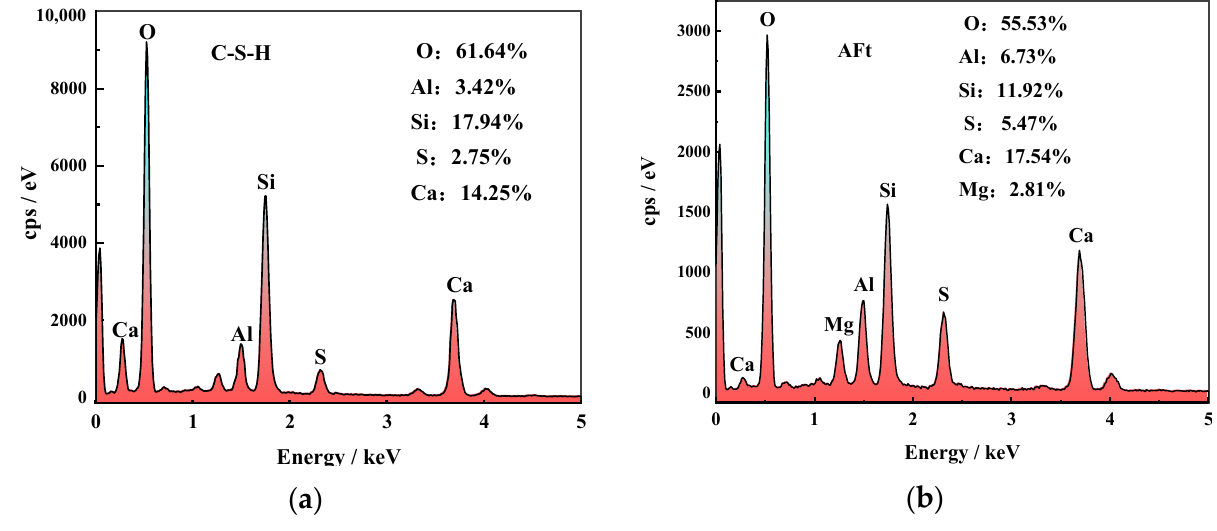
Figure 11. EDS energy spectra: ( a ) C-S-H gel and ( b ) AFt.